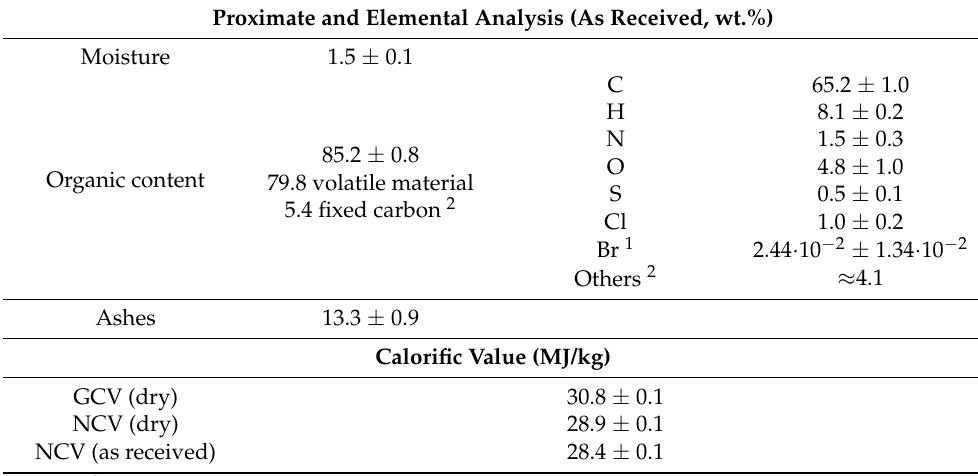
Table 3. Characterization of fuel properties of the fine